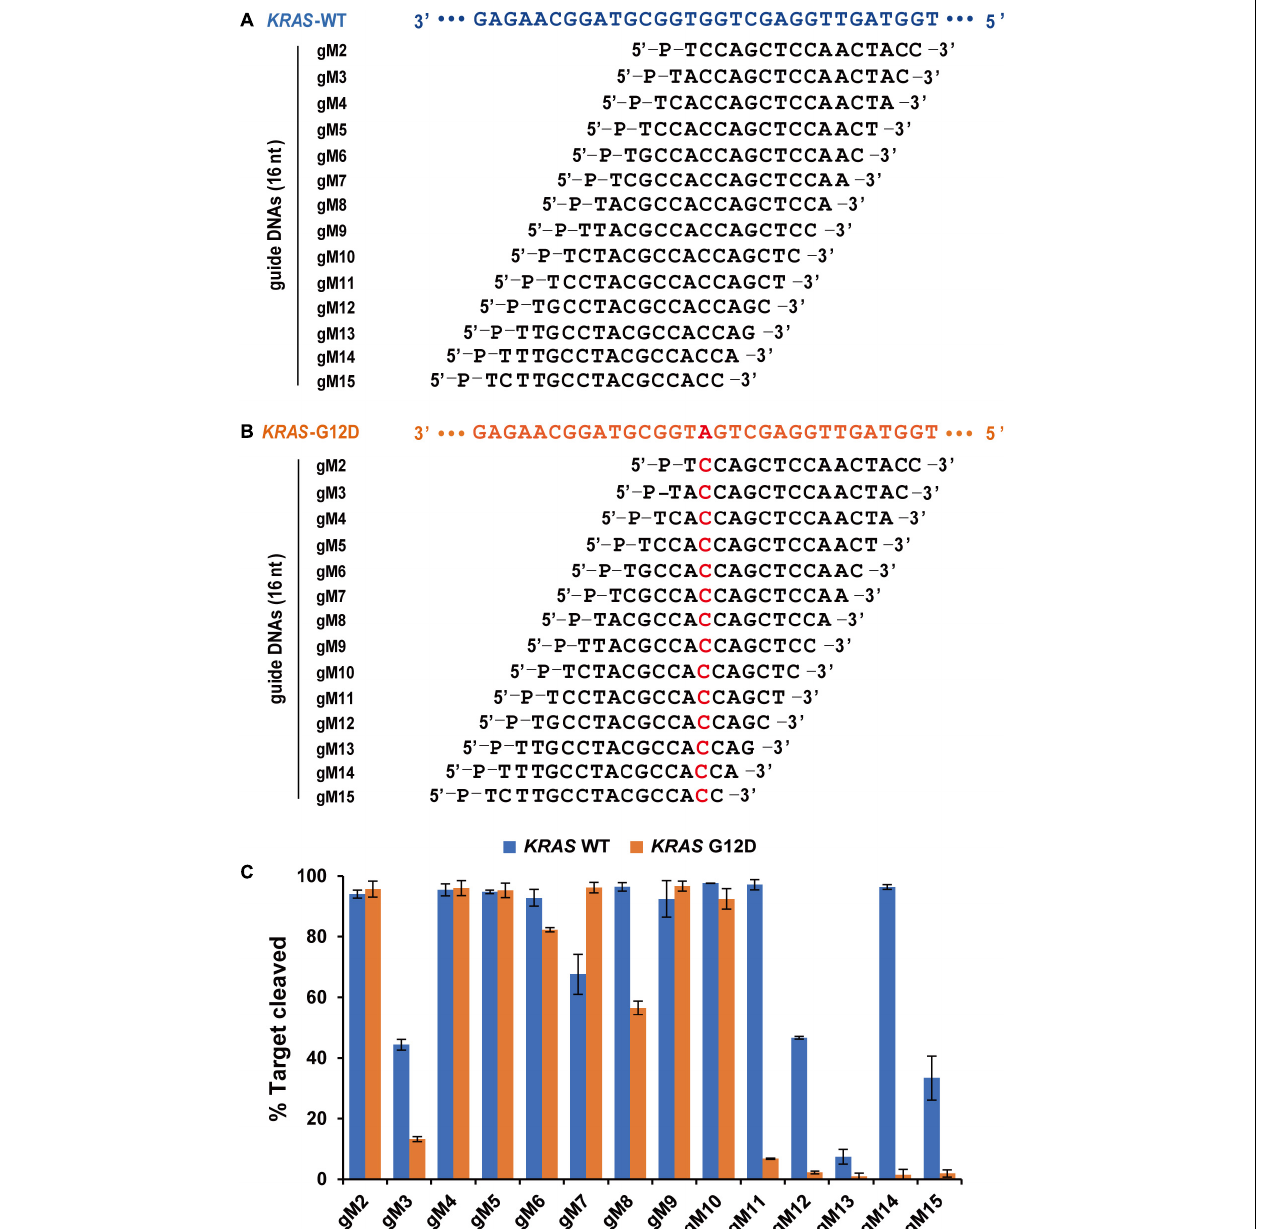
functions as a DNA-guided DNA endonuclease that requires specific DNA helicase can enhance thermophilic TtAgos activity by strand invasion and unwinding of dsDNA (Hunt et al.,